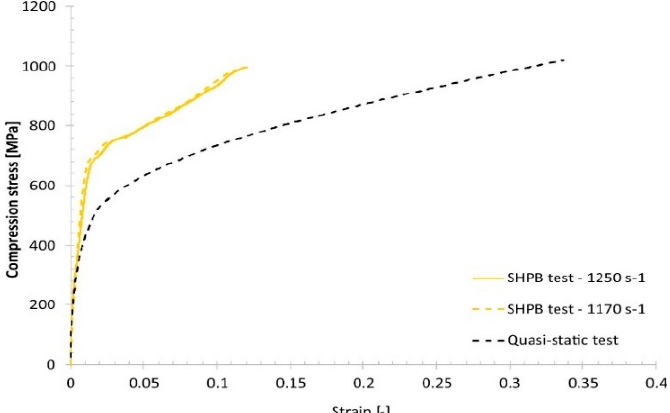
Figure 17. Comparison of the dynamic and quasi-static uniaxial compression test results obtained for specimen No. 17 .